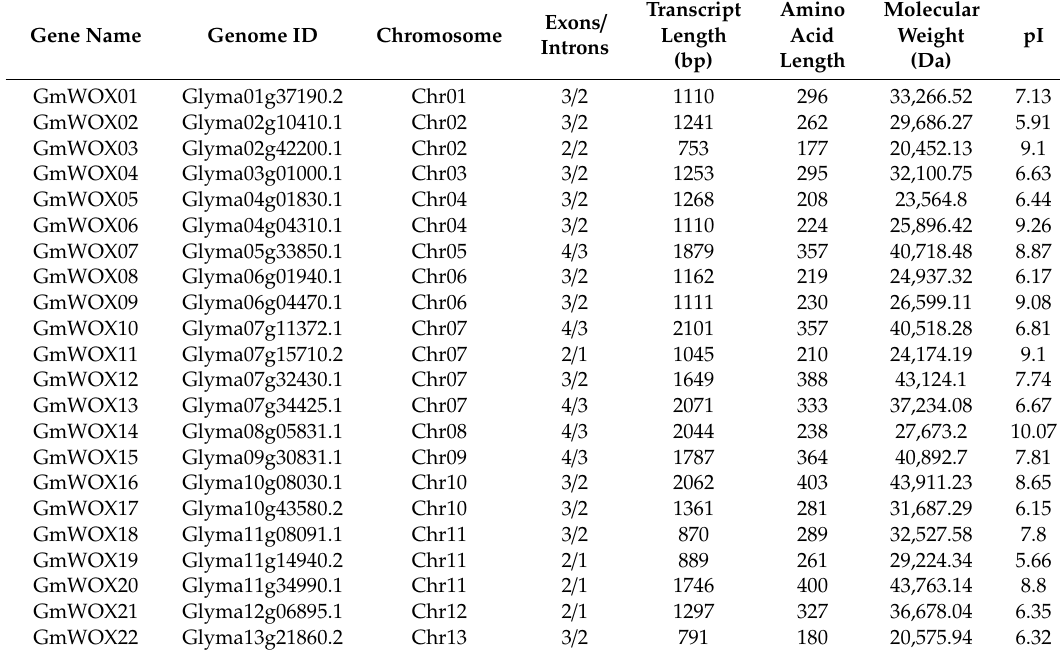
Table 1. GmWOX gene